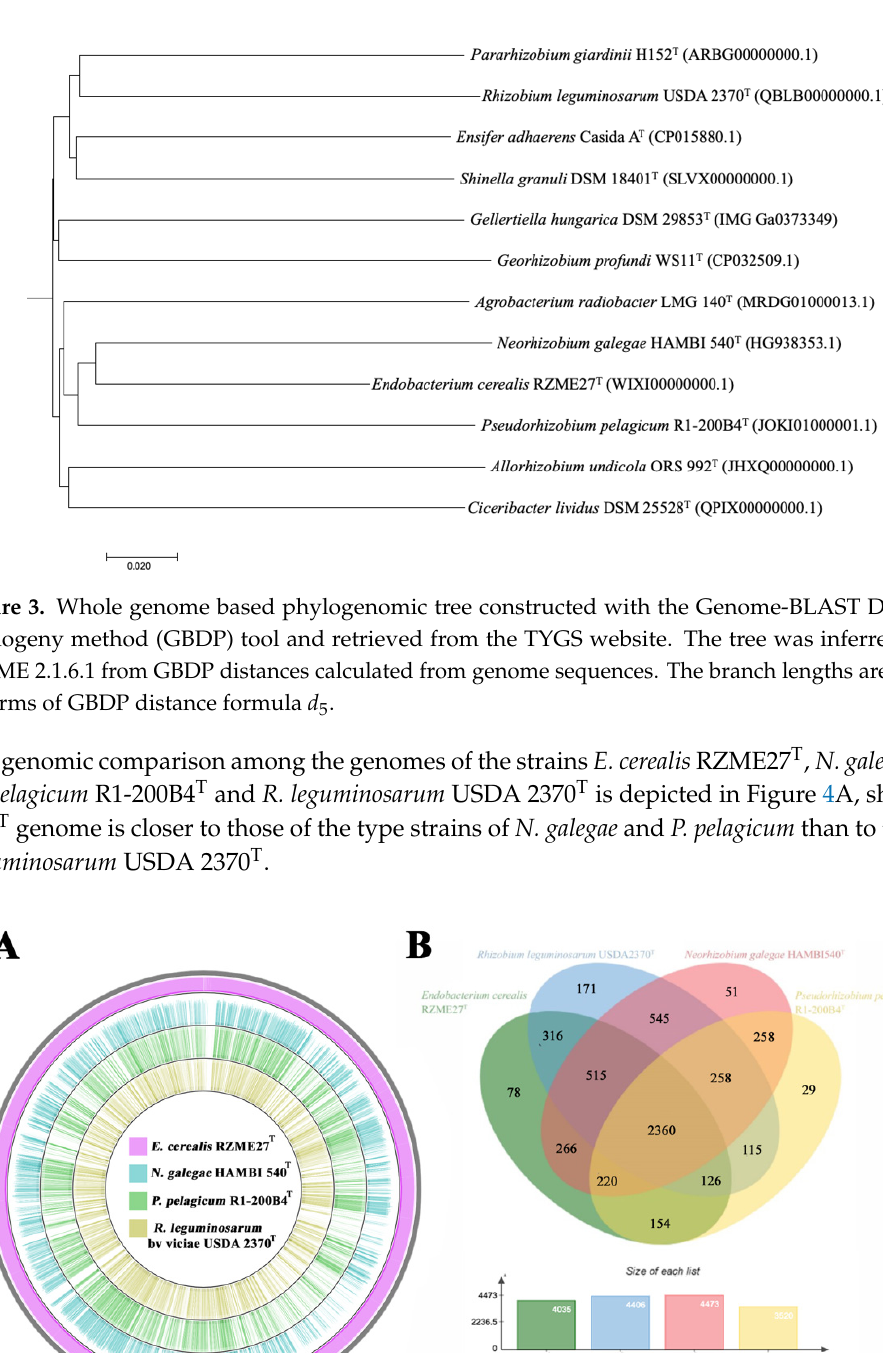
Table 3. Cellular fatty acid composition of Endobacterium cerealis , its closest related genera and the type species of the type genus of family Rhizobiaceae . Fatty Acid *